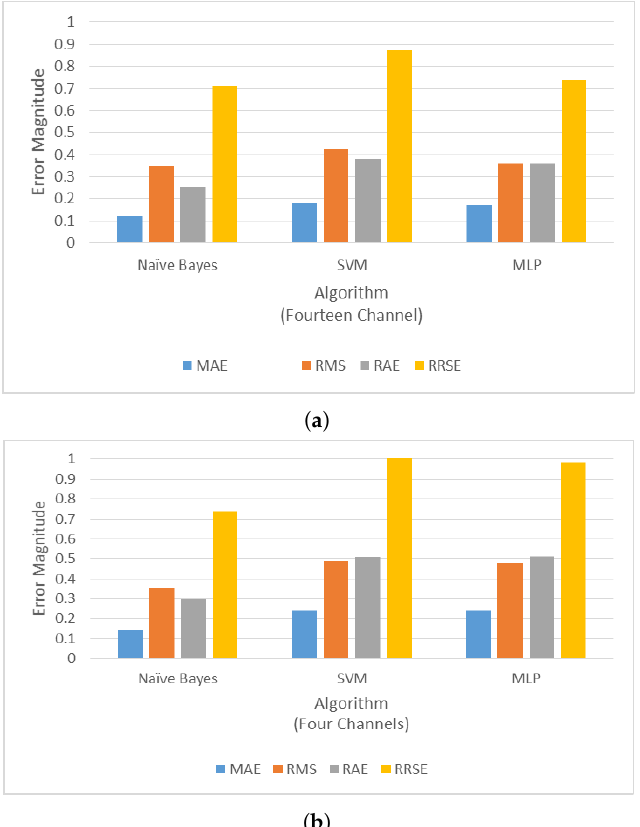
Figure 8. Error magnitudes of different algorithms used: ( a ) fourteen channels; ( b ) four selected channels with higher